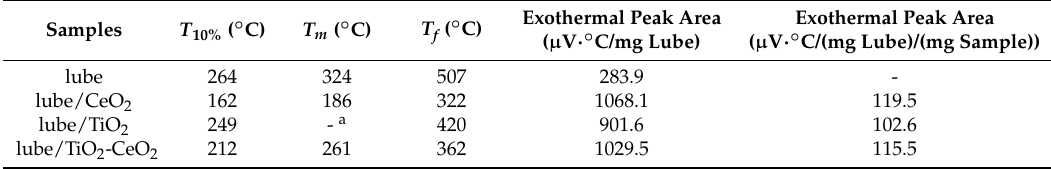
Table 2. Catalytic performances for the combustion of SOF over the prepared catalysts.